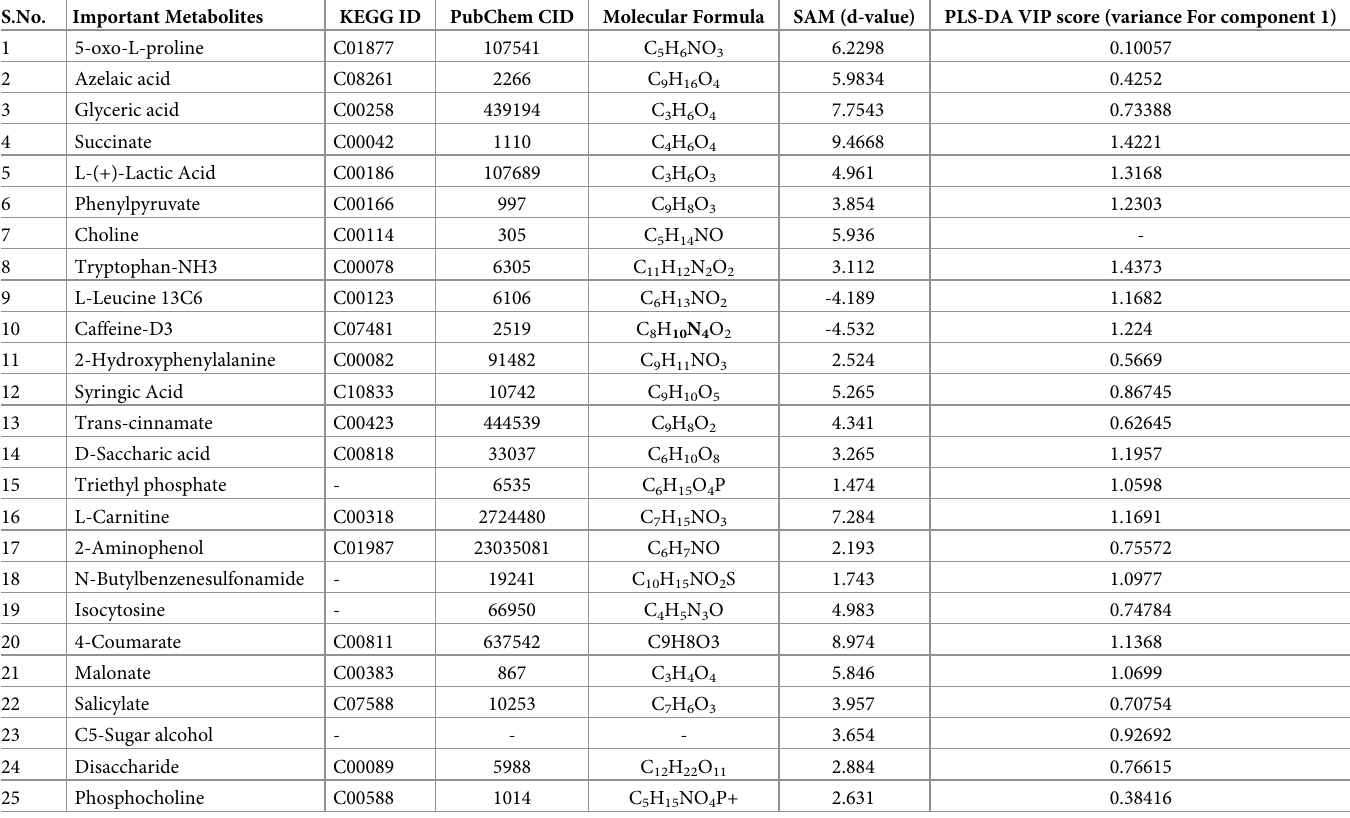
Table 2. Important metabolites with their compound ID (KEGG ID/PubChem CID and molecular formula, identified through partial least square discrepant anal- ysis (PLS-DA) and significant analysis of metabolites (SAM) across genotypes and treatments.